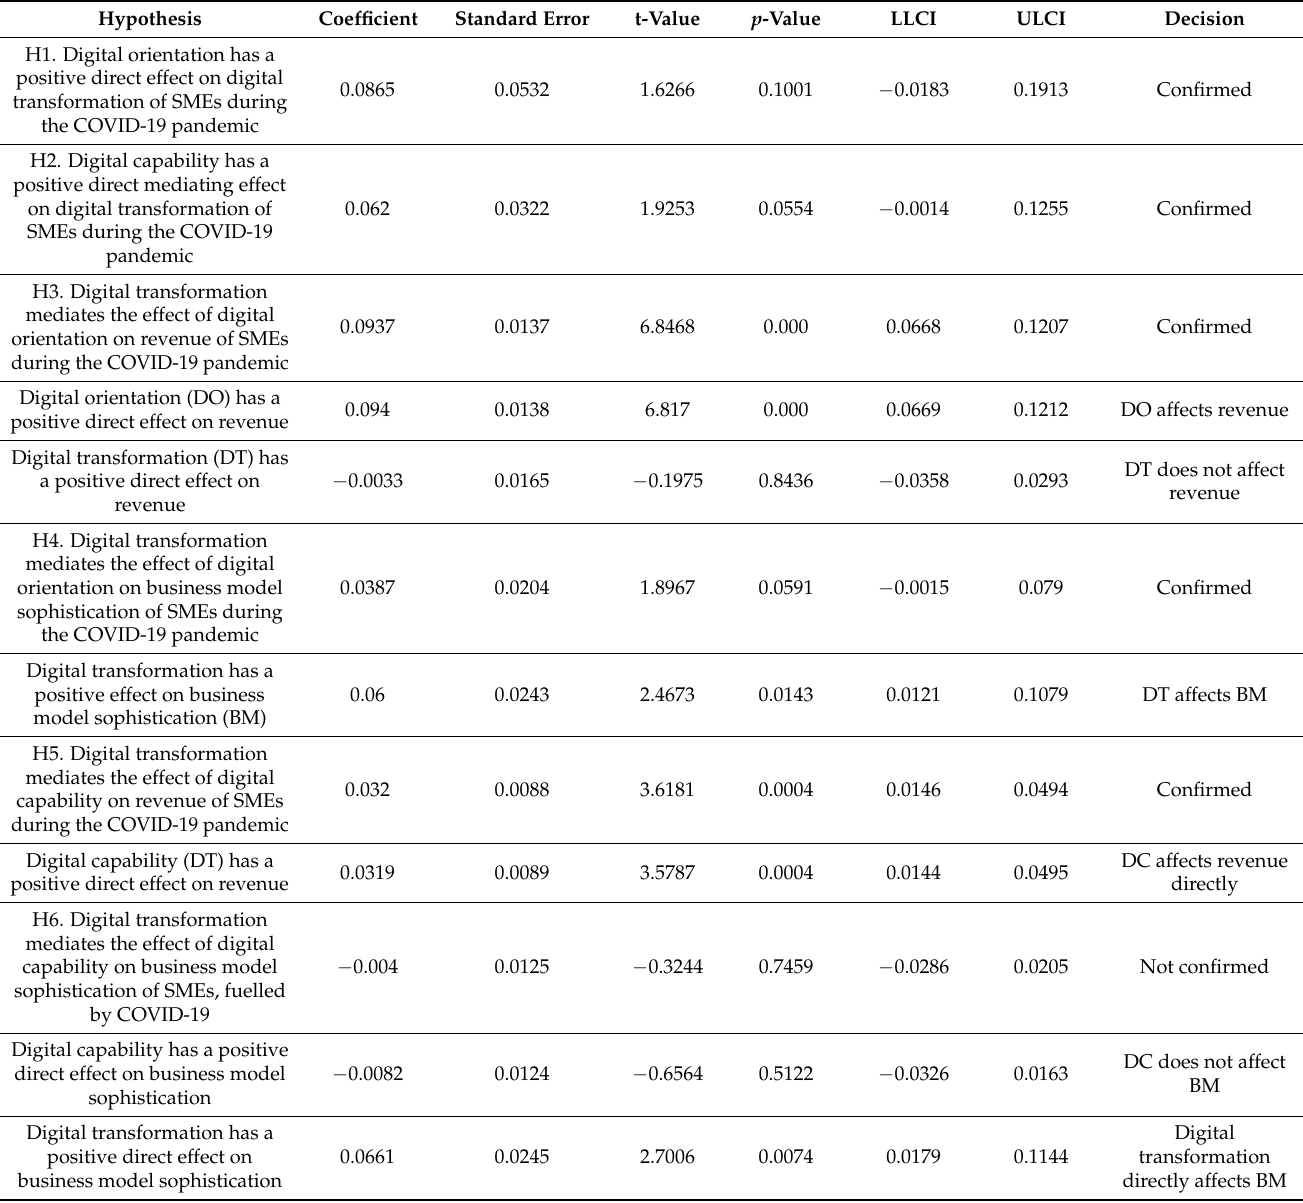
Table 4. Hypothesis testing